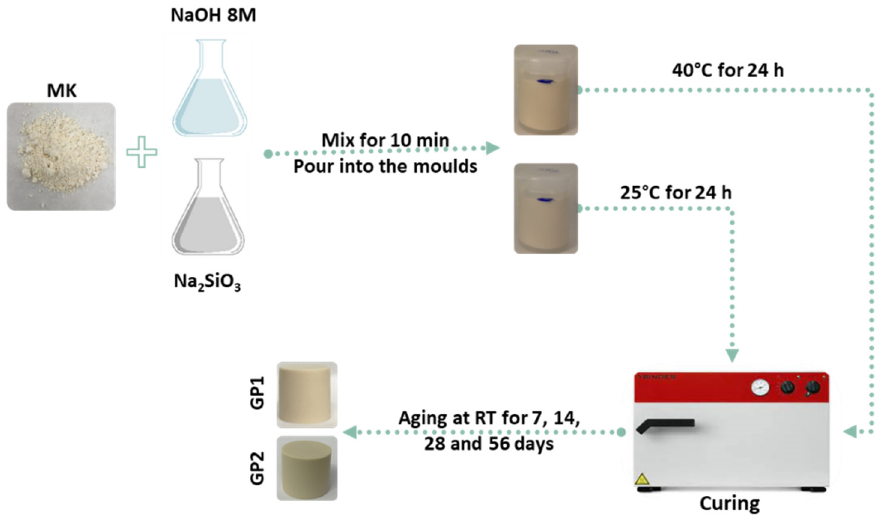
Figure 3. Flow diagram procedure of white geopolymer synthesis.